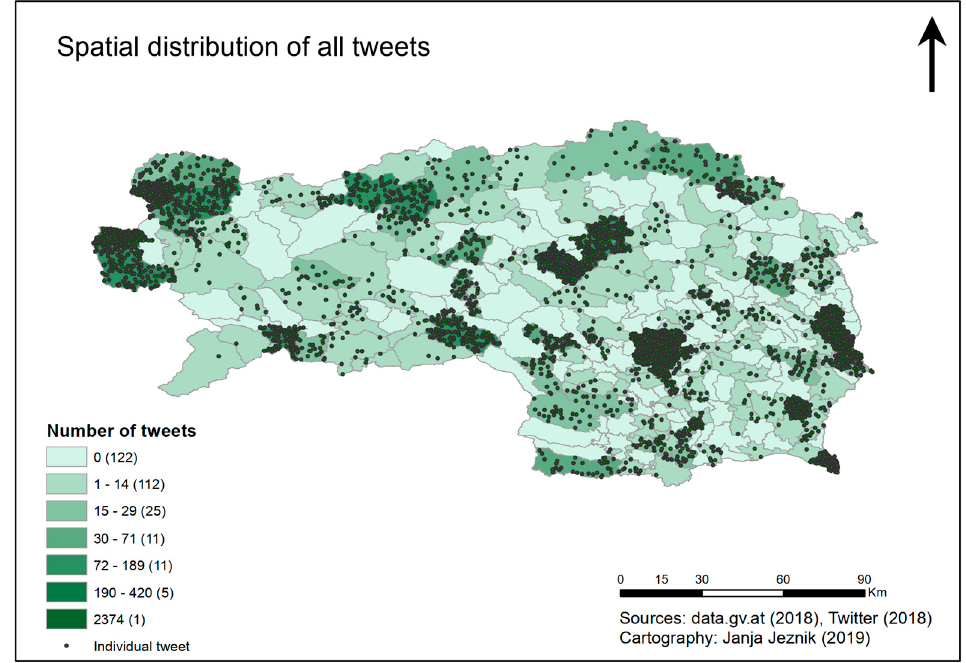
Figure 5. Spatial distribution of the tourism-related tweets according to the districts of the Province of Styria. Each district is colored according to the absolute number of tweets in the evaluation period and each individual tweet is represented by a green dot in the map.